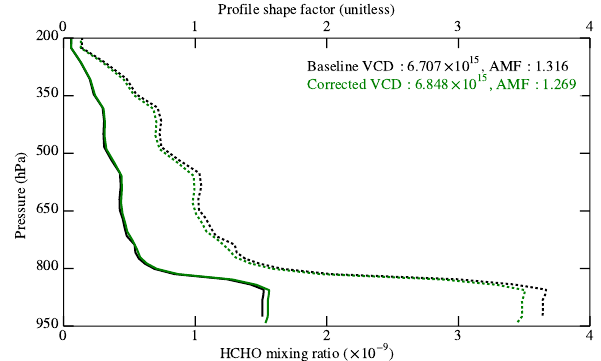
Figure 5. Effect of the vertical profile pressure correction (Sect. 5.4 of main text) for a scan over the Ecuadorian Andes (78 ◦ W 1 ◦ N); with HCHO mixing ratios taken from a GEOS-Chem 4 ◦ × 5 ◦ sim- ulation (solid line) along the bottom x axis and corresponding cal- culated shape factor S (dotted line) on the top axis. The corrected model HCHO profile is shifted upwards and reduced in magnitude as a result of the lower surface pressure value on which to base the profile. Scattering weights are accordingly reduced, acting to reduce the AMF for this scan, and subsequently increase the calcu- lated HCHO